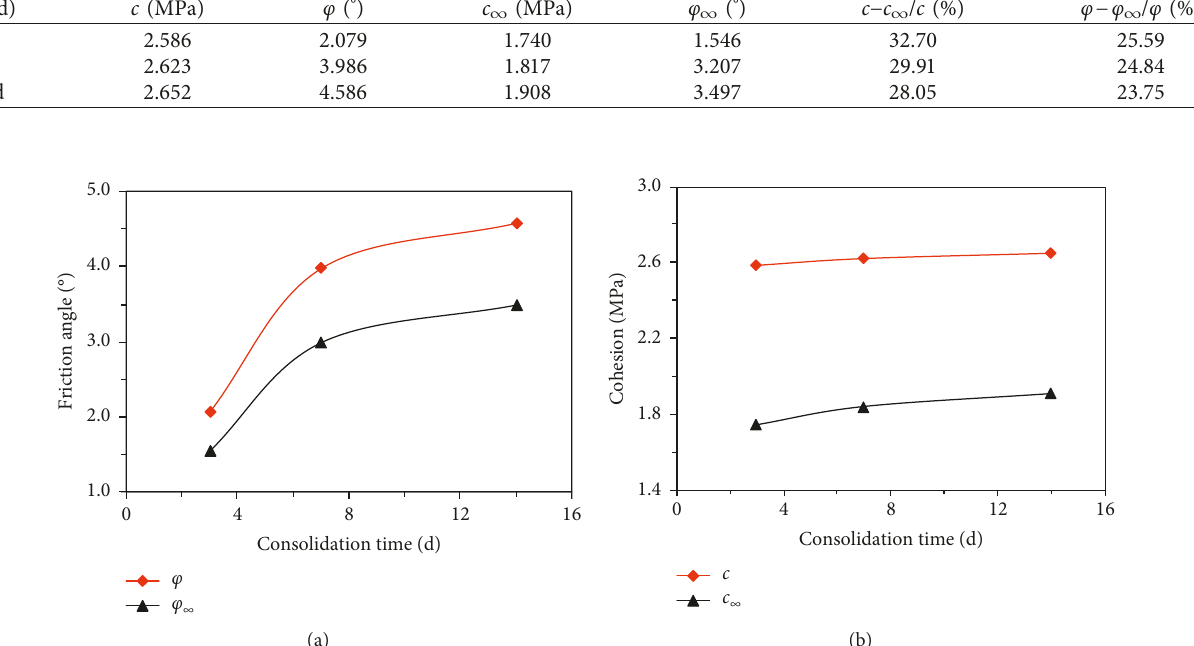
Figure 11: Variations in instantaneous and long-term Mohr–Coulomb strength parameters vs. t